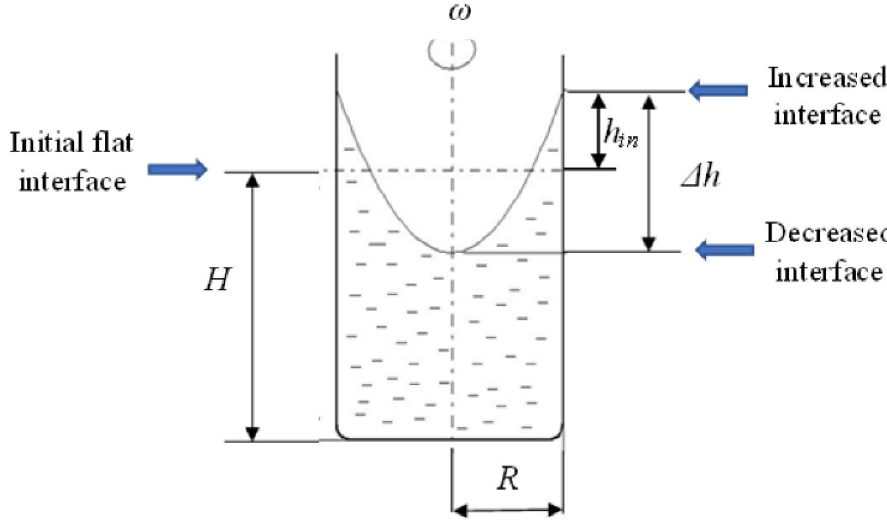
Figure 1. The effect of the rotating magnetic field (RMF) on the melt shape during stirring.